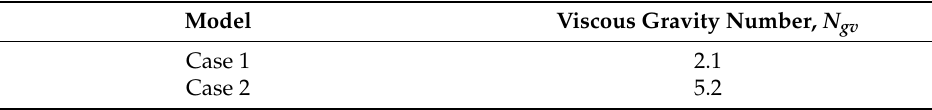
Table 10. Viscous gravity numbers of Cases 1 and 2.